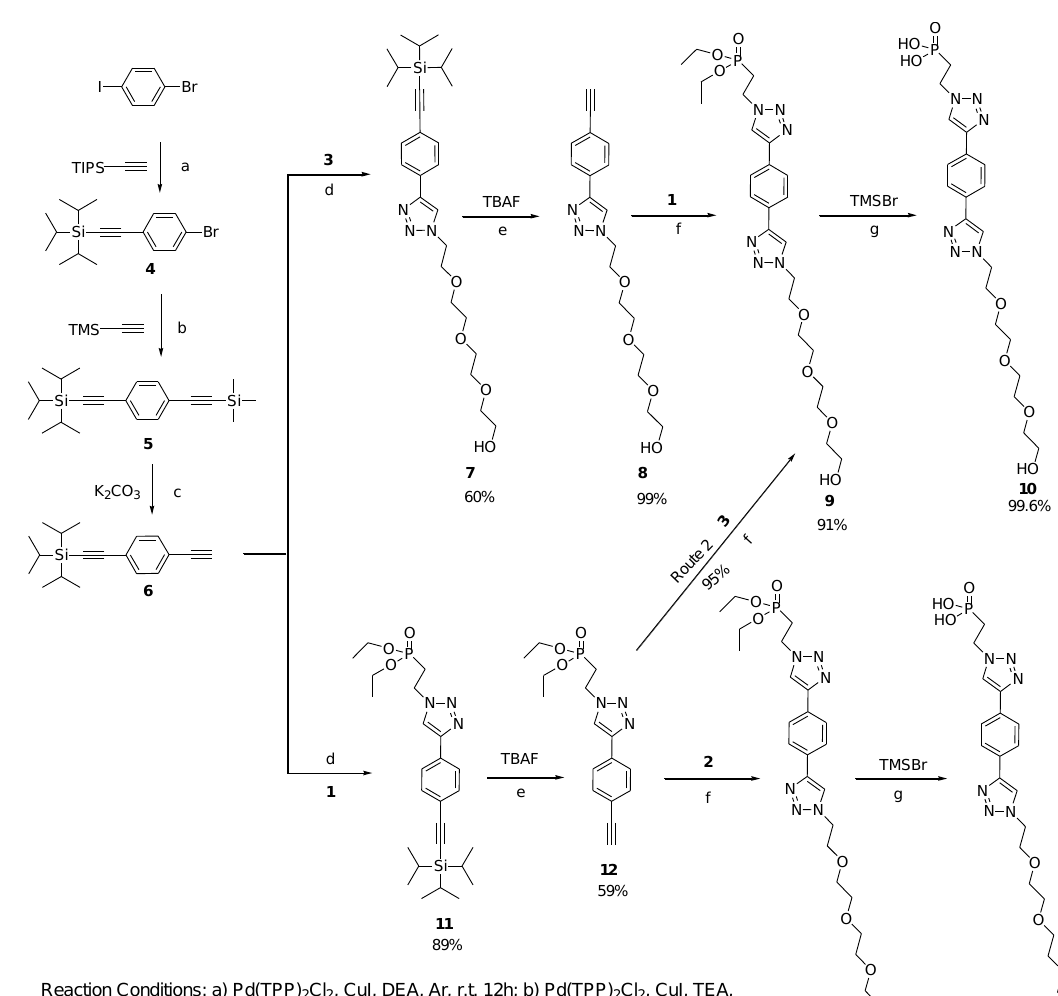
Scheme 1. Synthetic elaboration of phosphonate-two tetraethylene glycol (TEG)-OH ( 10 ) and phosphonate-TEG-Me ( 14